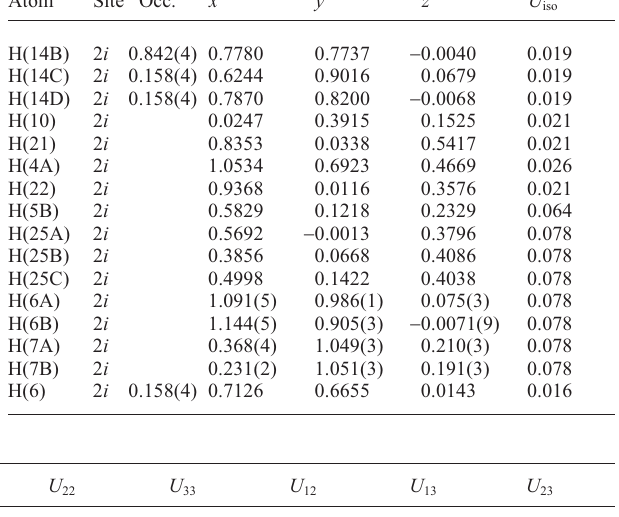
Table 2. Atomic coordinates and displacement parameters (in Å 2 ) . Atom Site